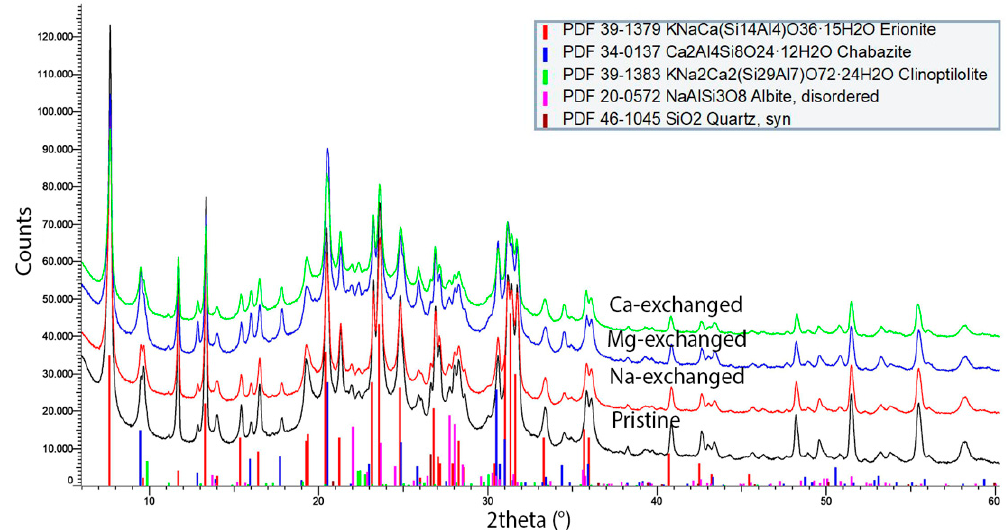
Figure 4. Experimental diffraction pattern of the various samples. Coloured vertical bars mark the position of the Bragg reflection of the various minerals.